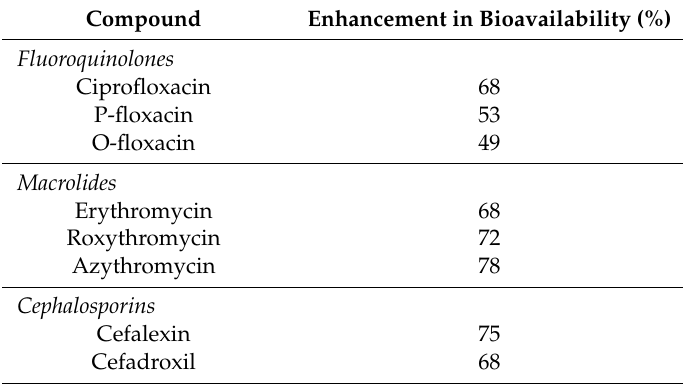
Table 2. Maximal enhancement of the bioavailability of APIs, vitamins and amino acids claimed to occur when ginger extracts are taken concomitantly